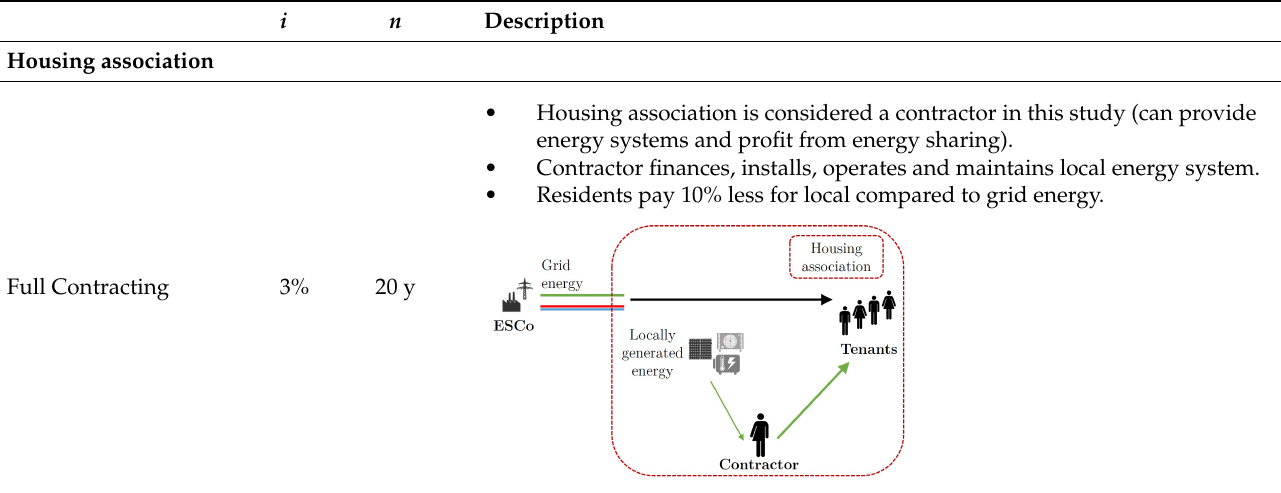
Table 2. Considered business cases, interest rates and depreciation